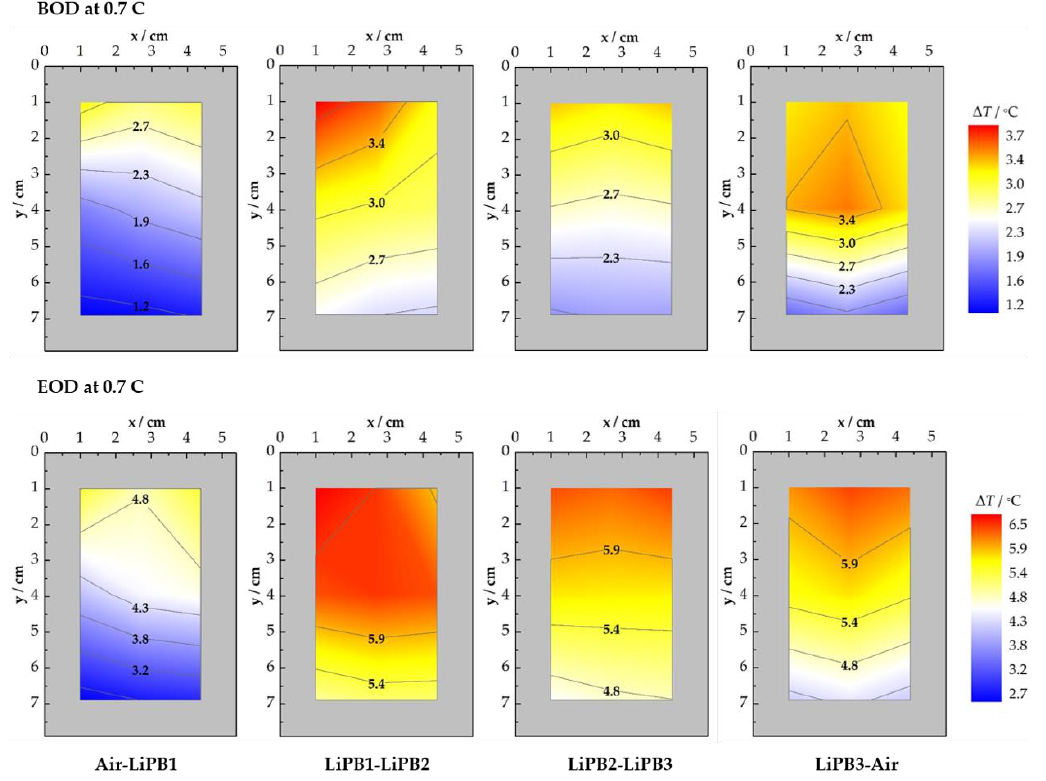
Figure 7. Spatial and temporal thermal mapping of the LiPB pack at the BOD and EOD instances, for CC discharge at 0.7 C.